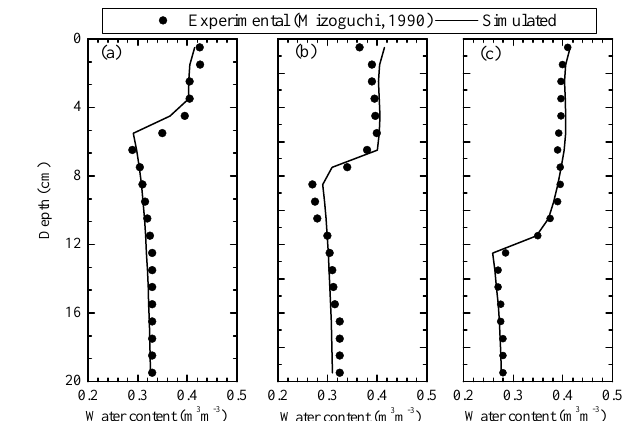
Figure 8. Comparison of total water content (ice + liquid) between experimental (Mizoguchi, 1990, as cited by Hansson, 2004) and coupled CA model results: (a) 12, (b) 24, and (c)